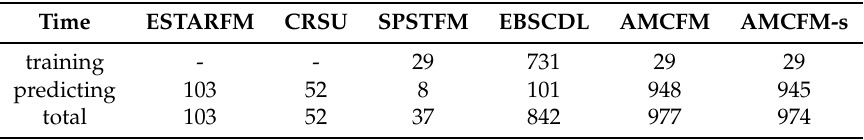
Table 10. Computational cost (in seconds).